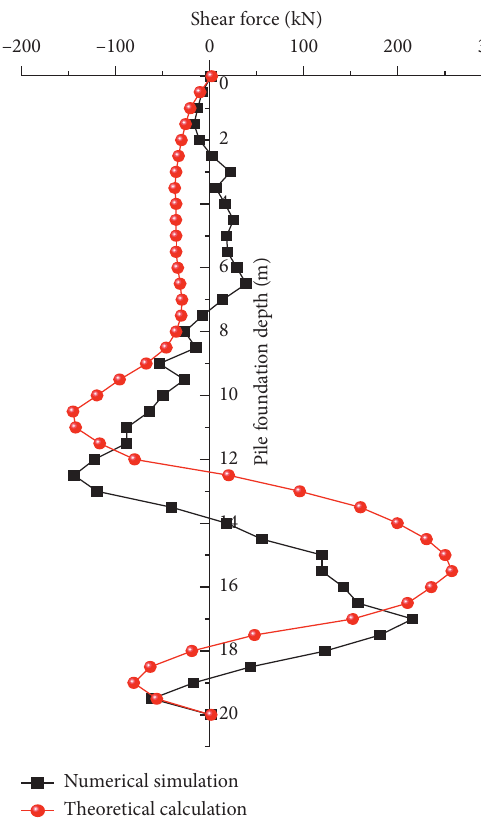
Figure 18: Shear force of pile in